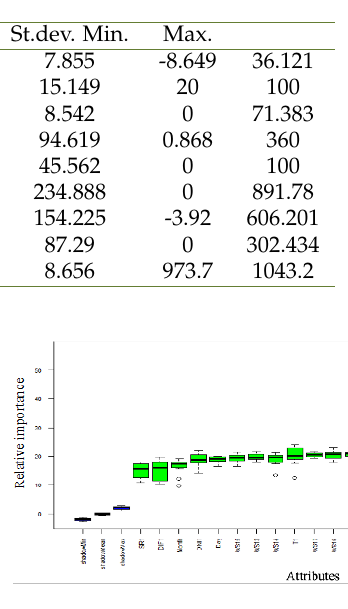
Table 1. Summary statistics of weather characteristics in Basel 2018-2020.